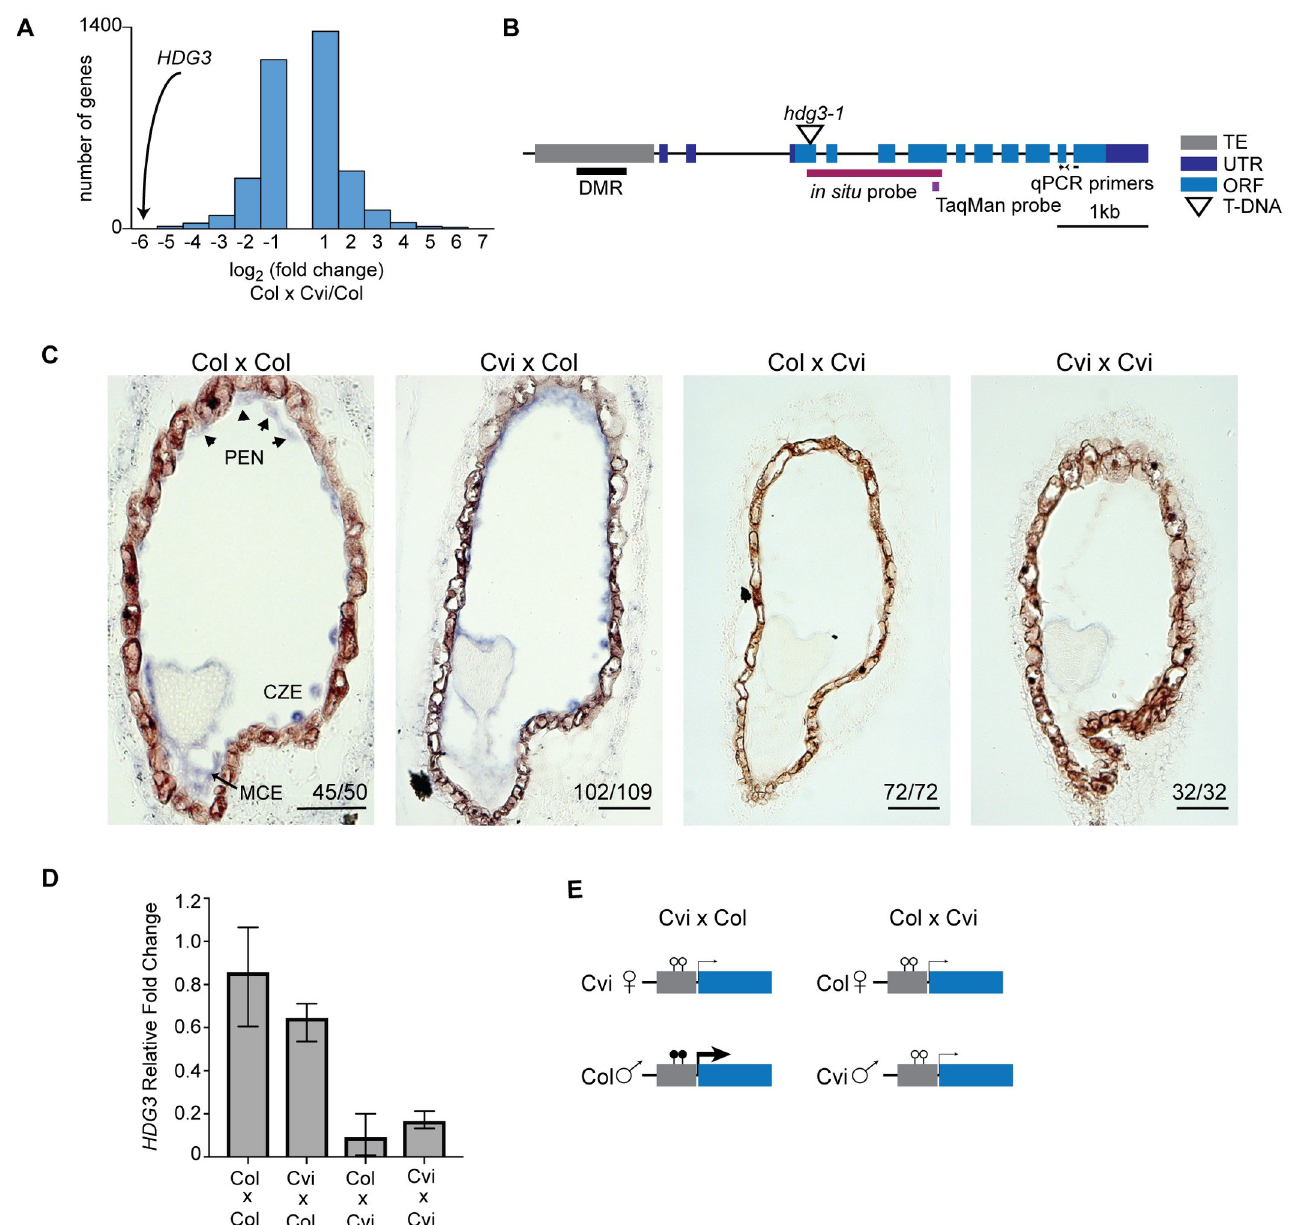
Fig 1. Natural variation in imprinting is associated with differences in HDG3 expression levels. (A) HDG3 expression is decreased in Col x Cvi endosperm compared to Col, as determined by mRNA-seq. (B) Schematic of the HDG3 locus. DMR, differentially methylated region. (C) In situ hybridization of HDG3 (purple) in F 1 seeds from the indicated crosses. Female parent is written first. In crosses where Col is the male parent, HDG3 is detected in the micropylar (MCE), peripheral (PEN), and chalazal (CZE) endosperm. Arrowheads indicate nuclear-cytoplasmic domains in the PEN. Number of seeds with shown pattern out of total seeds assayed is in corner of each image. Scale bars, 50 μ m. (D) RT-qPCR analysis of relative HDG3 transcript abundance in F 1 endosperm. Values are the average of 3 biological replicates, bars represent upper and lower range. (E) Schematic representation of relationship between HDG3 methylation, expression, and imprinting in endosperm. Thickness of arrows denotes relative expression level. Lollipops represent methylated (filled) and unmethylated (open)